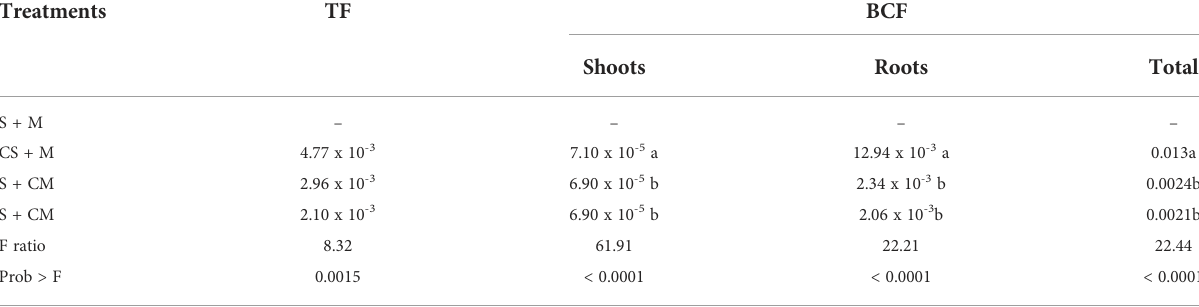
TABLE 2 Translocation factor (TF) and bioconcentration factor (BCF) in calla lily plants grown in substrates with or without enro fl oxacin addition.